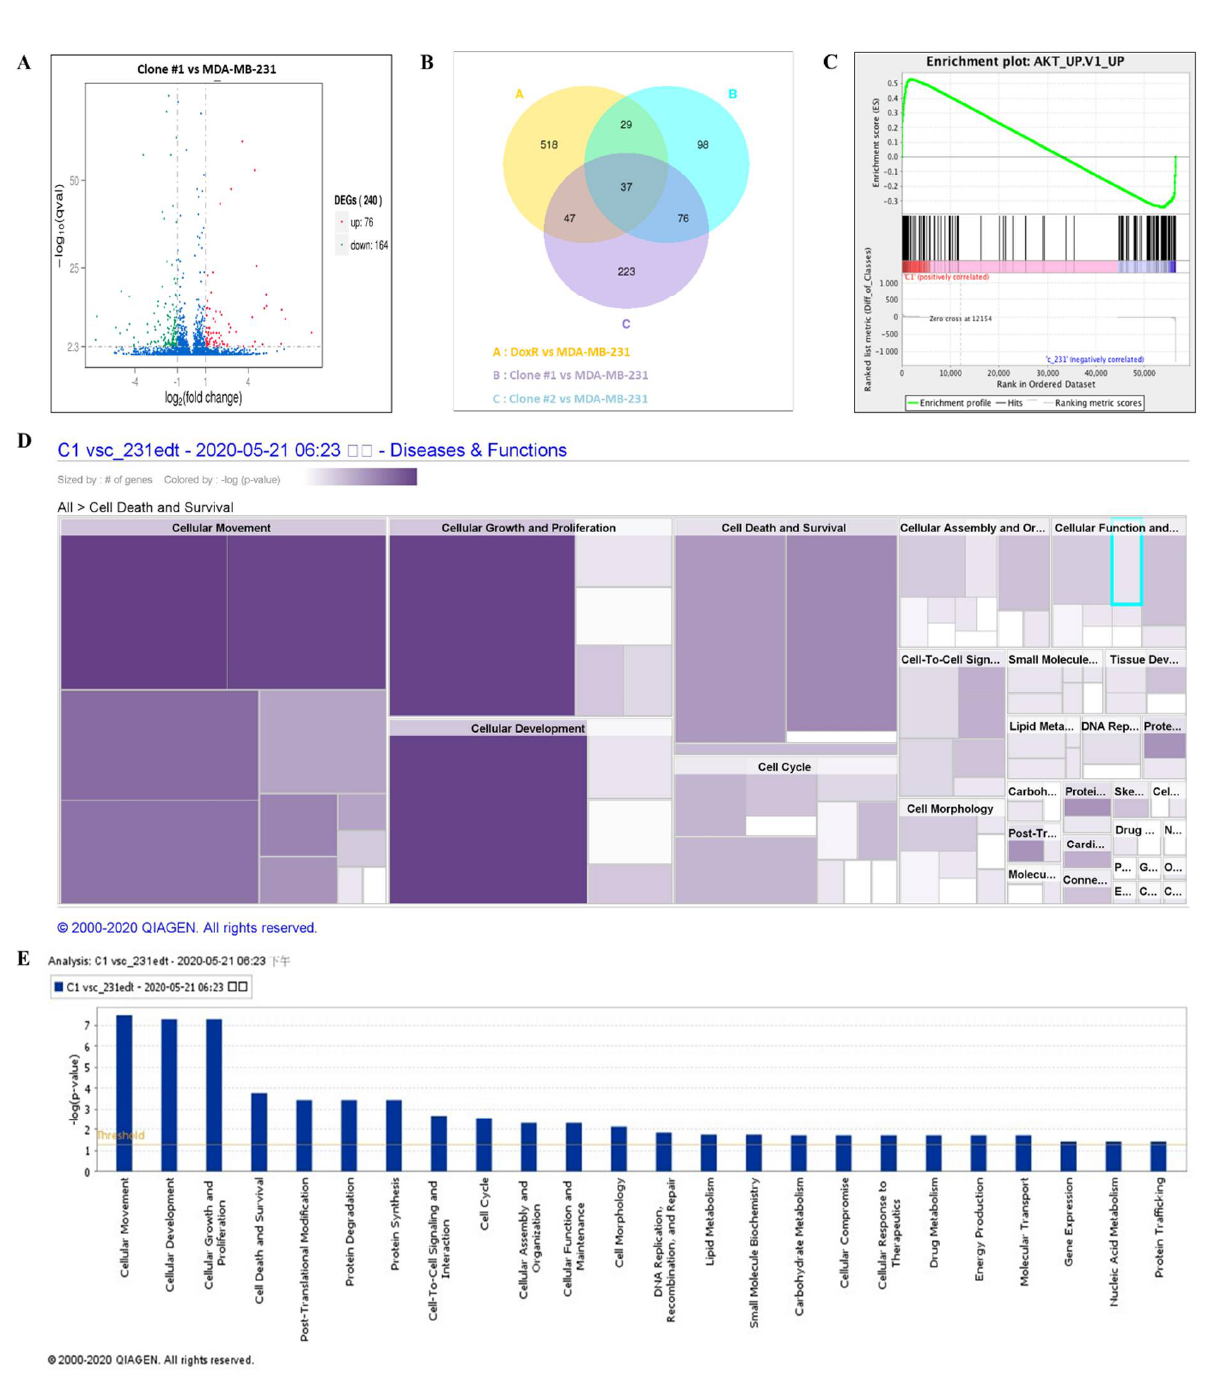
cells (Figure S4A,B). Next, ingenuity pathway analysis (IPA-Qiagen) was performed using the NGS data. A detailed analysis of disease and function predictions revealed enhanced cellular movement, growth, proliferation, and development of breast cancer cells. However, a decline in the cellular death/apoptosis of breast cancer cells was observed (Figure 7D,E).